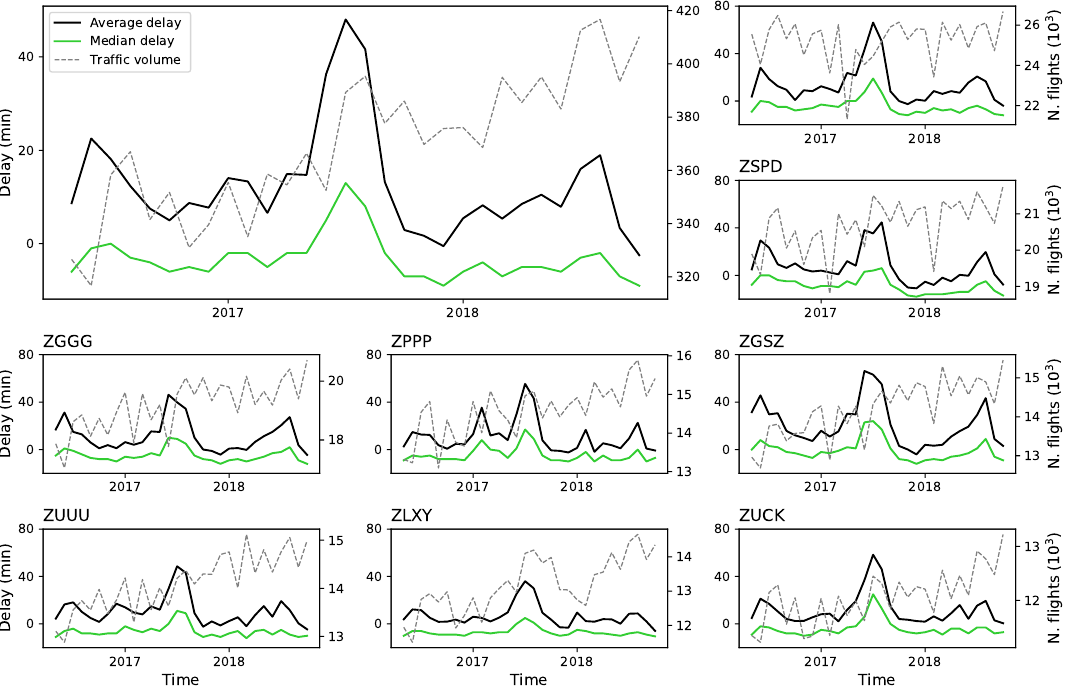
Figure 3. Delay evolution in China from May 2016 to October 2018. Each panel represents the evolution of the average (black lines) and median (green lines) of flight delays, calculated with a one month resolution; additionally, the dashed gray lines (right axis) depict the evolution of the number of flights (in thousands per month). The top left panel reports the aggregated results for the whole data set, while the other ones for the top-eight airports (ranked in decreasing number of